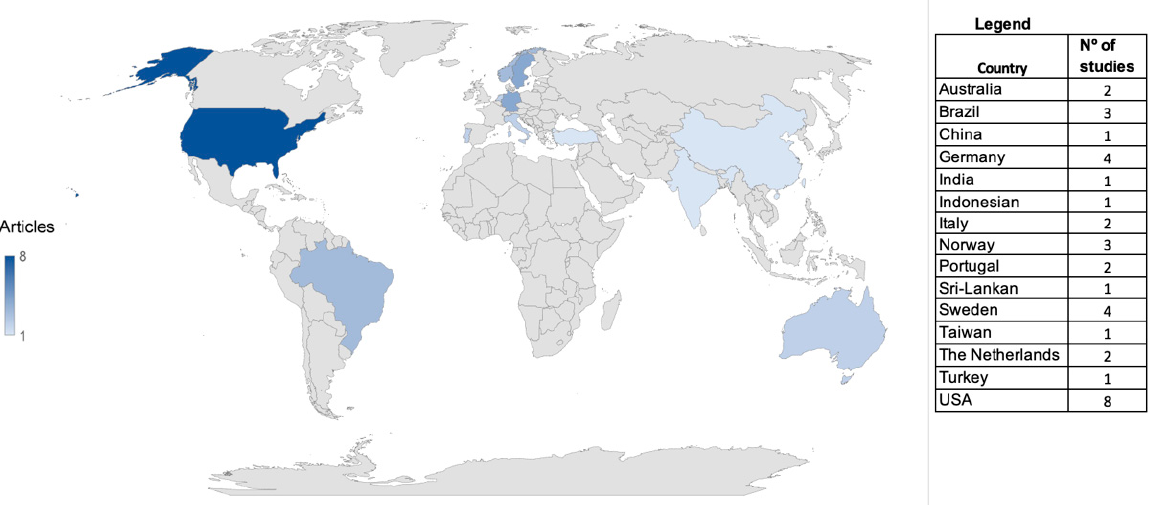
Figure 2. Countries of publication of studies reviewed.